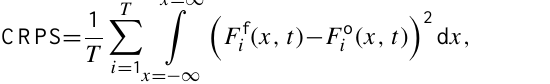
Table 2. Average skill scores for different hindcast scenarios for the EFAS system. Scores are averaged over different forecasting times and for different locations with discharge observation in the Upper Danube (Fig.